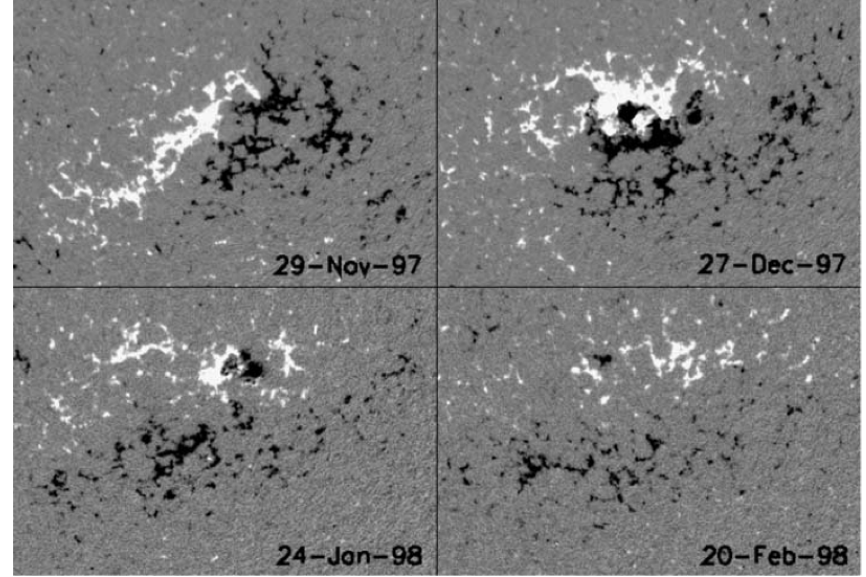
Figure 27: SOHO/MDI magnetic maps showing AR 8100 during rotations two to five. The main polarities of the active region undergo a strong clockwise rotation. Image reproduced with permission from Green et al. (2002), copyright by